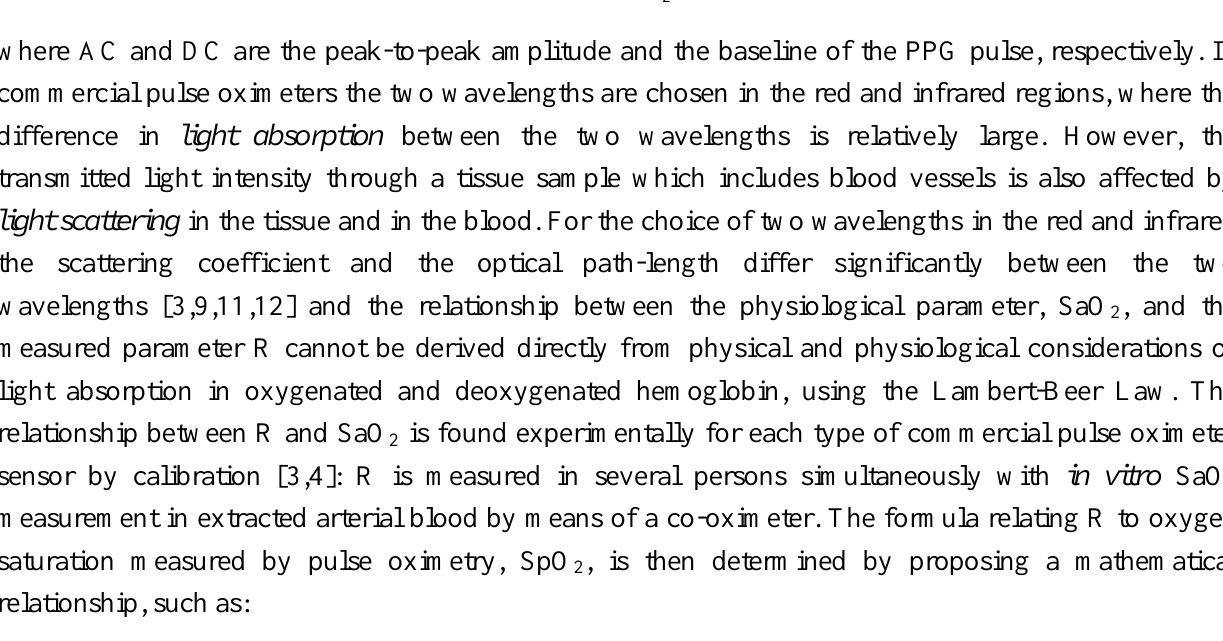
and I represent the maximal and minimal light D S